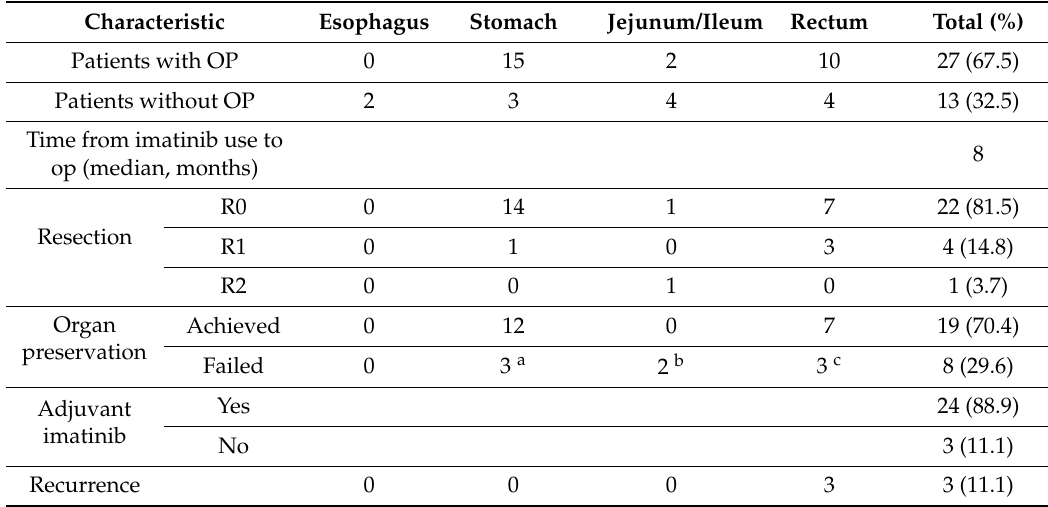
OP, operation. a Splenectomy and distal pancreatectomy ( n = 1), splenectomy ( n = 1), cholecystectomy and duodenal tumor resection ( n = 1). b Appendectomy and right salpingectomy ( n = 1), En-bloc duodenectomy and resection of jejunum and left hemicolectomy ( n = 1). c Partial resection of vagina ( n = 2), abdominal perineal resection and prostatectomy ( n =